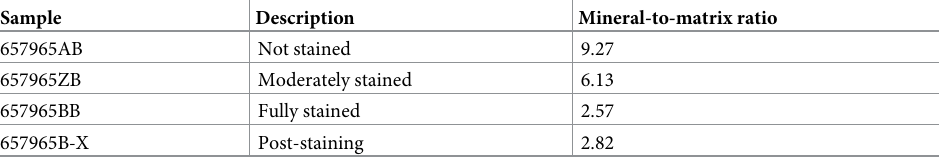
Table 4. Mineral-to-matrix ratios obtained from ATR-FTIR analysis of a specimen stained with Lugol’s iodine before, during, and after